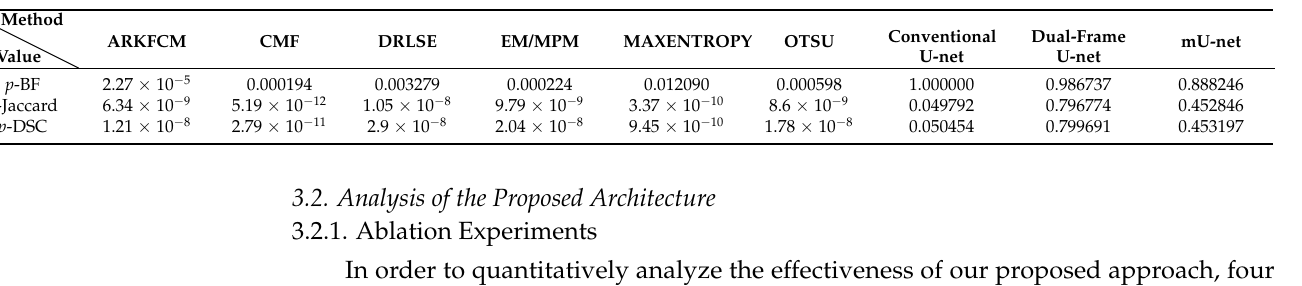
Table 3. Statistical T-test difference between each comparison method and our proposed